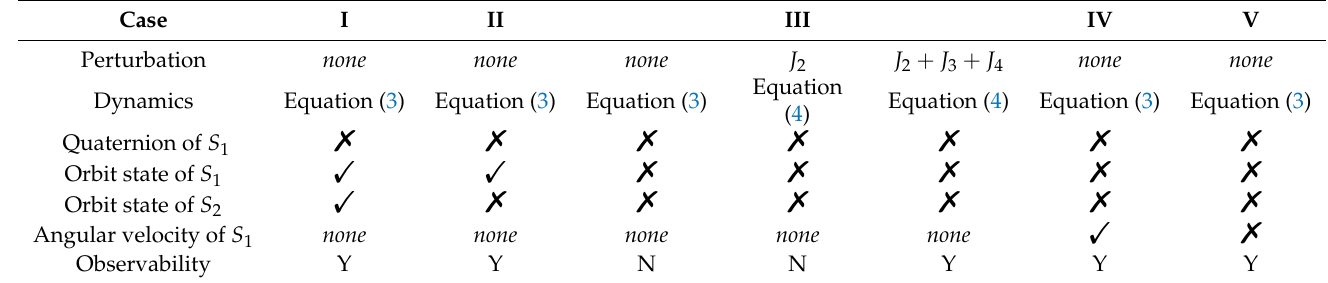
Table 7. Observability under different